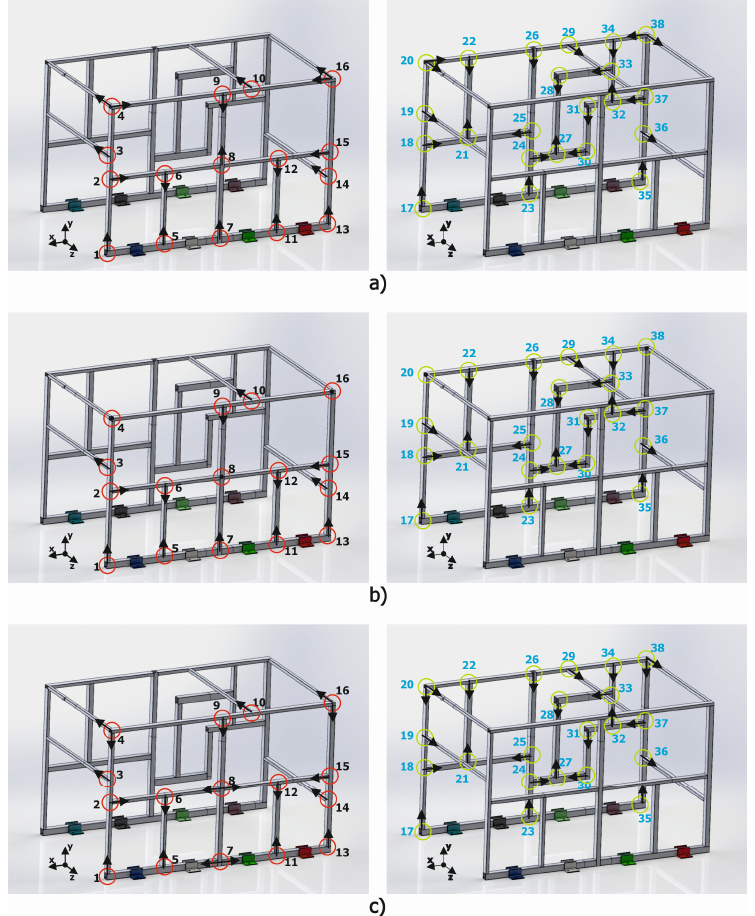
Figure 14. Joint configurations analyzed. Variant ( a ), Variant( b ) and Variant ( c ).